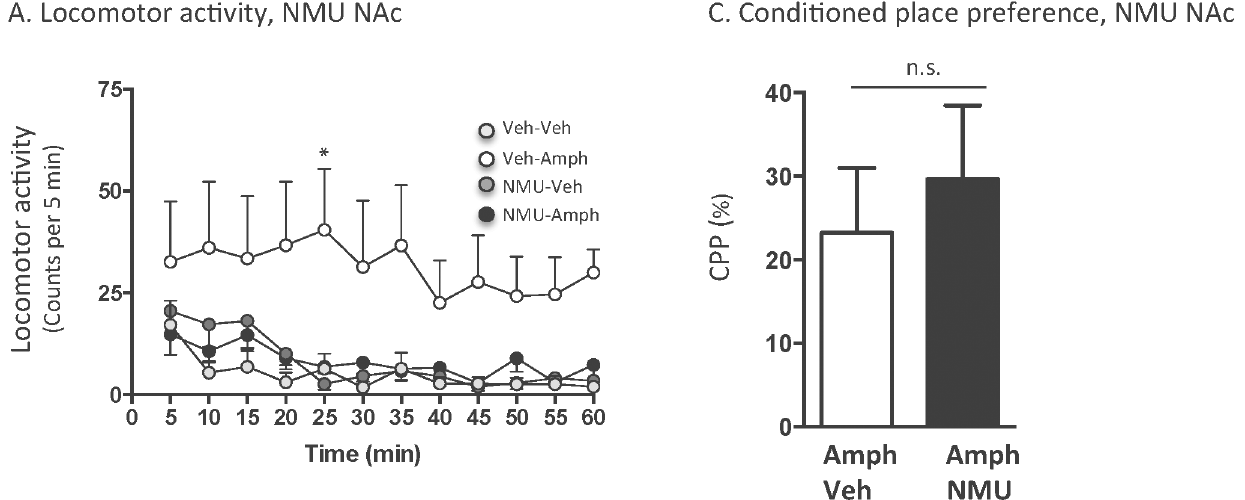
Fig 4. Accumbal administration of NMU attenuates amphetamine-induced locomotor stimulation, but does not affect the expression of conditioned place preference in mice. (A) Amphetamine-induced (2 mg/kg, ip) locomotor stimulation was attenuated by an accumbal injection of NMU (62.5 ng per side). Accumbal NMU administration had no effect per se on locomotor activity. (B) Accumbal NMU (62.5 ng per side, Amph-NMU) administration did not attenuate amphetamine-induced (2 mg/kg, ip, Amph-Veh) expression of CPP in mice. Data are presented as mean ± SEM (n.s. P > 0.05, * P <